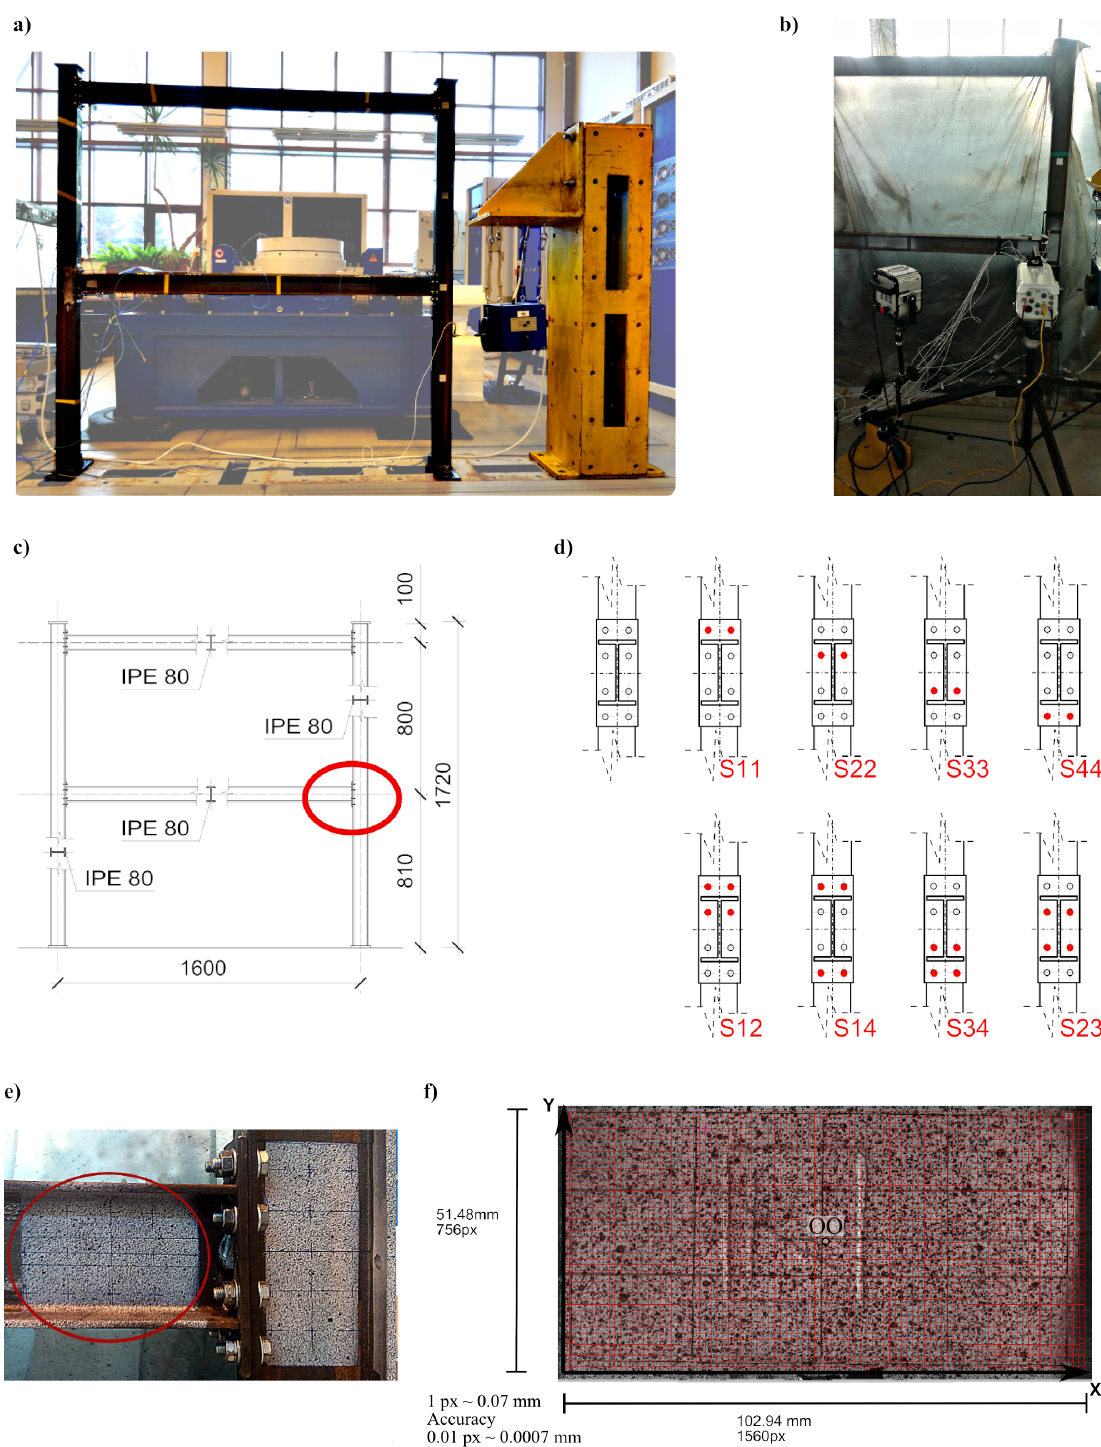
Figure 2. ( a ) The examined structure before testing, ( b ) the node under examination, ( c ) a scheme of the structure with its dimensions and cross sections, where the observed connection is marked with a red oval, ( d ) realized scenarios of the anomalies’ appearances, ( e ) a connection prepared for Digital Image Correlation (DIC) examinations (with a speckled pattern), ( f ) a picture registered by the camera, with the net of measured points (on every crossing of red